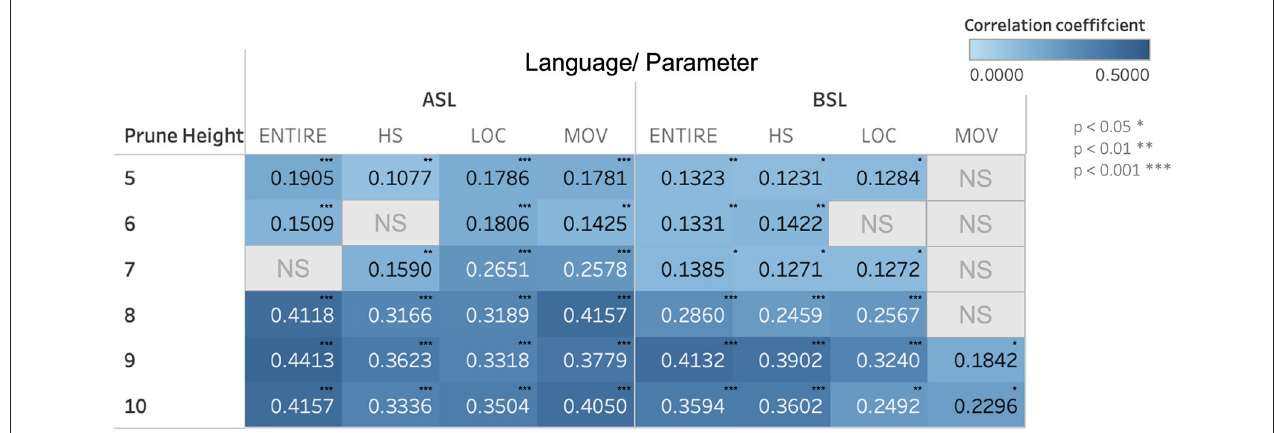
FIGURE 7 | Pearson’s correlation coefficients between semantic and phonological similarity for the 100-dimension semantic vector space for ASL and BSL. Correlation coefficients are listed for all of the parameters combined (“ ENTIRE ”) and each of the parameters individually (“ HS ” = handshape, “ LOC ” = location, and “ MOV ” = movement). Relationships that were not significant are marked with